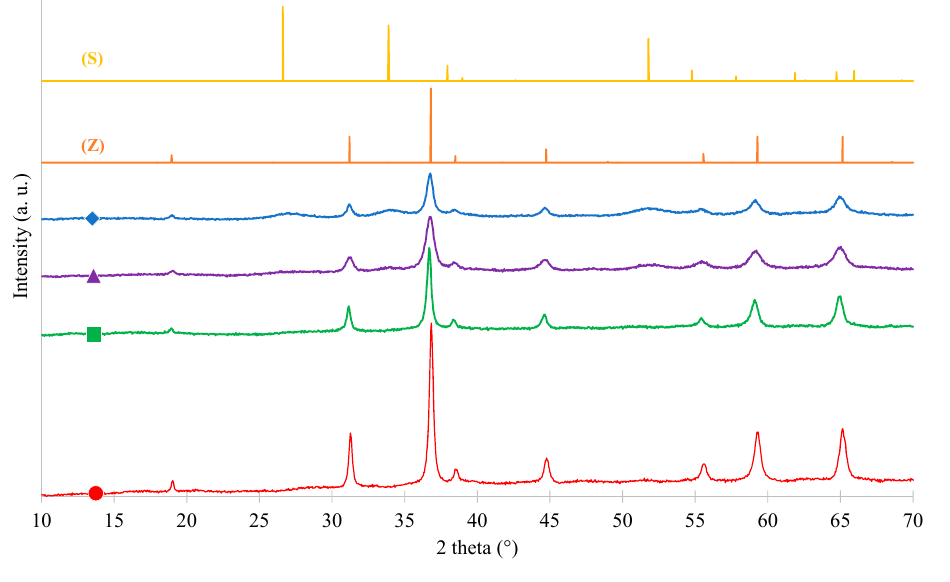
Figure 1. X-ray di ff raction (XRD) patterns of samples: ( (cid:8) ) Pure ZnCo 2 O 4 , ( (cid:4) ) ZnCo 2 O 4 / SnO 2 -10%, ( (cid:78) ) ZnCo 2 O 4 / SnO 2 -20% and ( (cid:7) ) ZnCo 2 O 4 / SnO 2 -30%. (Z) Reference pattern of cubic spinel ZnCo 2 O 4 and (S) reference pattern of tetragonal rutile SnO 2